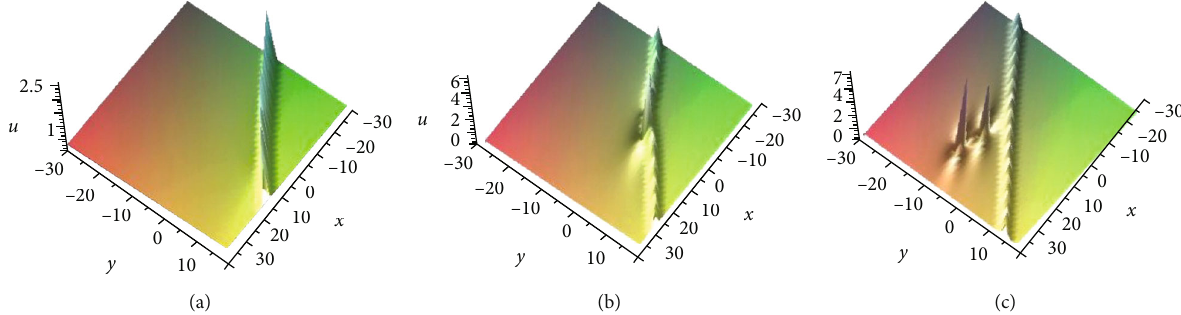
, where G is given by (34) with p 1 = 1 − i , q 1 = 1 + i , a = 1 , b = 1 , τ = 0 , c 12 = 1 , xx